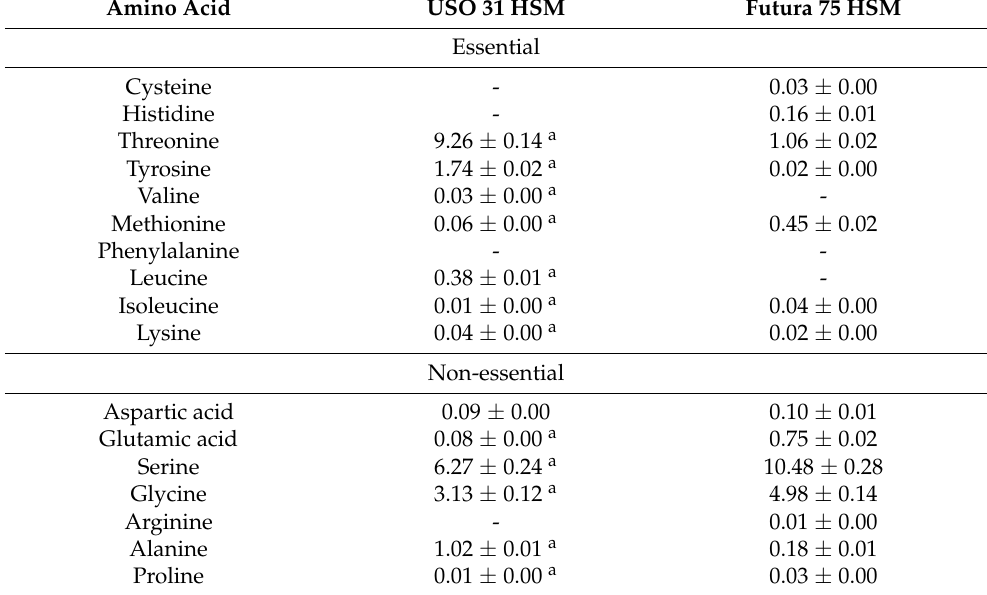
Table 6. Determination of amino acids in USO 31 and Futura 75 hempseed meal (HSM) by HPLC- FLD analysis. Data, which represent the mean ± standard deviations (SD) of three independent experiments ( n = 3), were expressed as g of each amino acid/100 g fresh weight